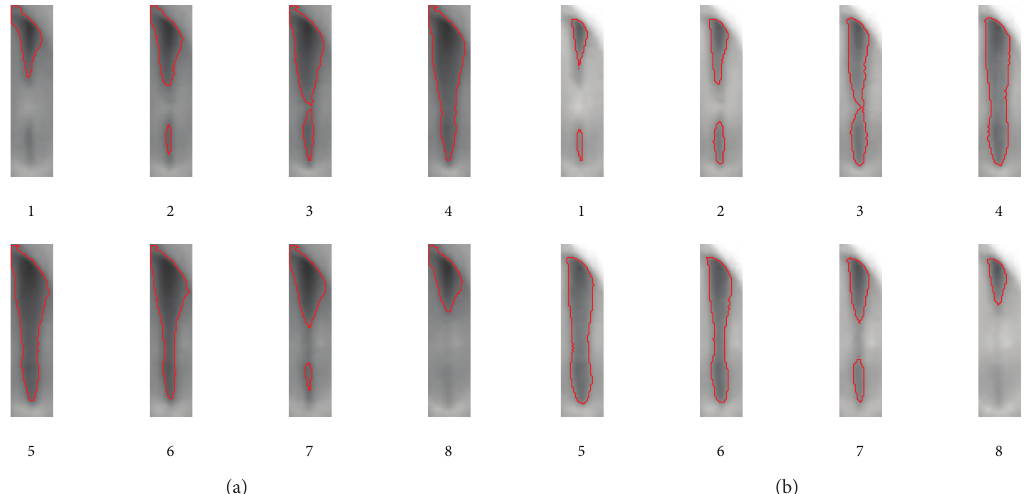
Figure 20: Case 2: Segmented HSV image sequence by the method of [7] (a), the proposed method (b).